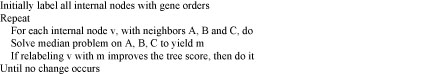
The scoring procedure of GRAPPA-IR when the tree is given.